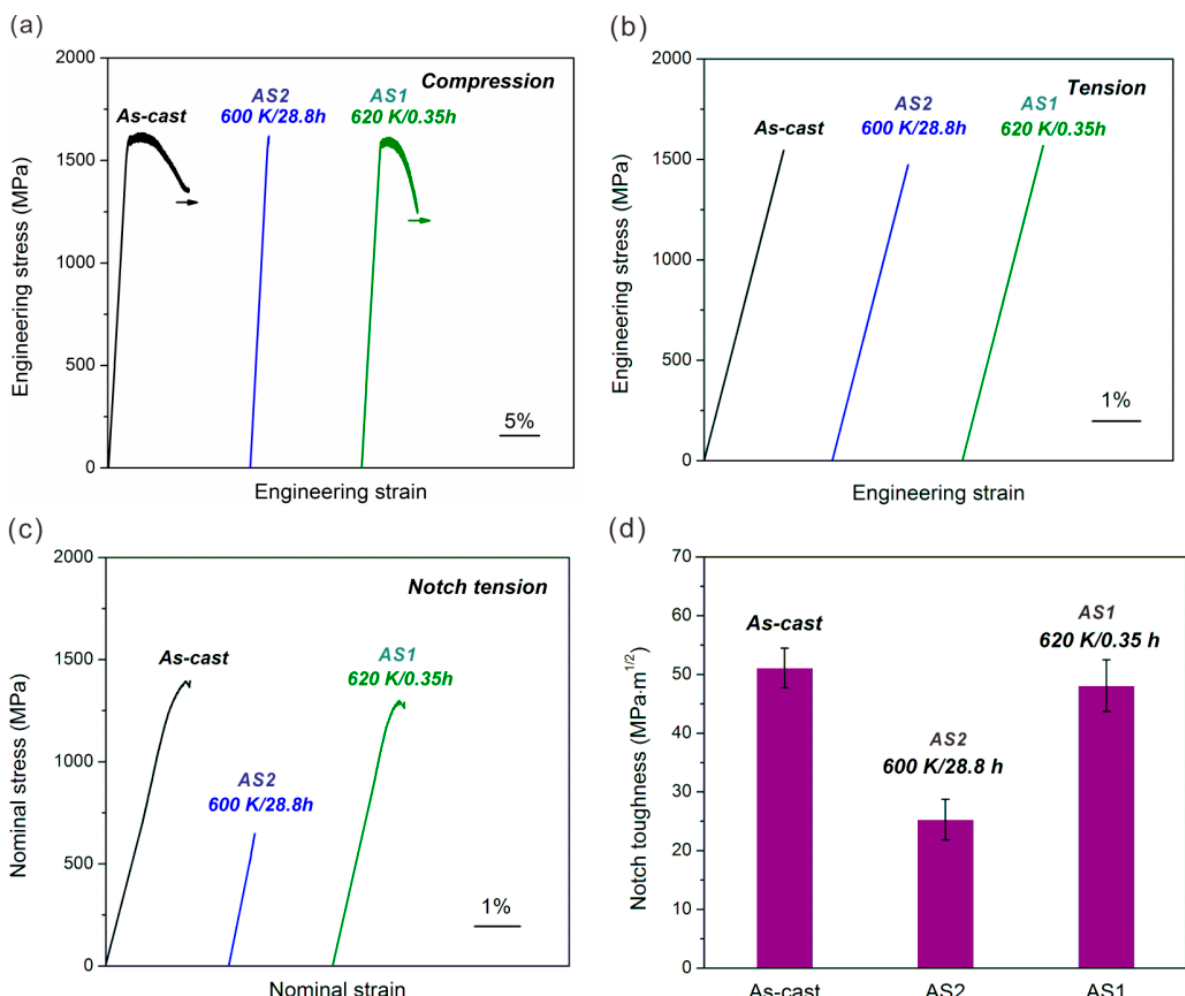
Figure 12. ( a , b ) Typical compressive and tensile engineering stress–strain curves of the as-cast and annealed MG samples; ( c , d ) notch tensile nominal stress–strain curve and notch toughness of the as-cast and annealed MG samples [53].